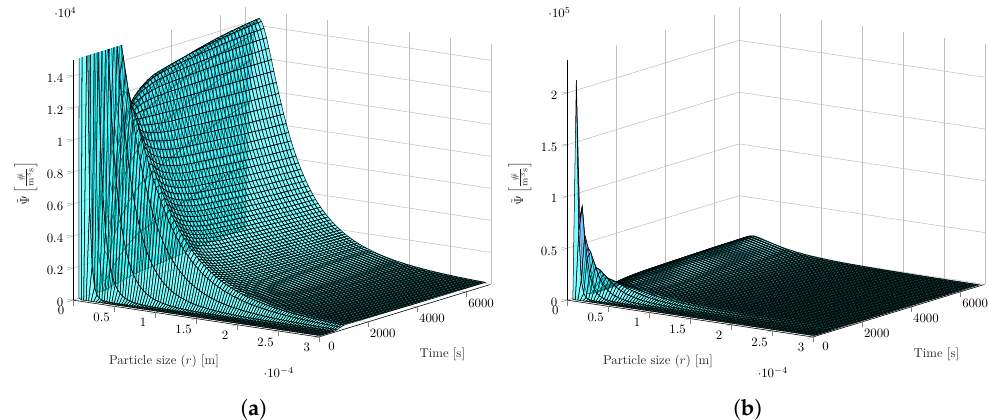
Figure 13. ( a ) Full scale; ( b ) zoomed scale of the particle distribution in the case of the non-isothermal batch system.